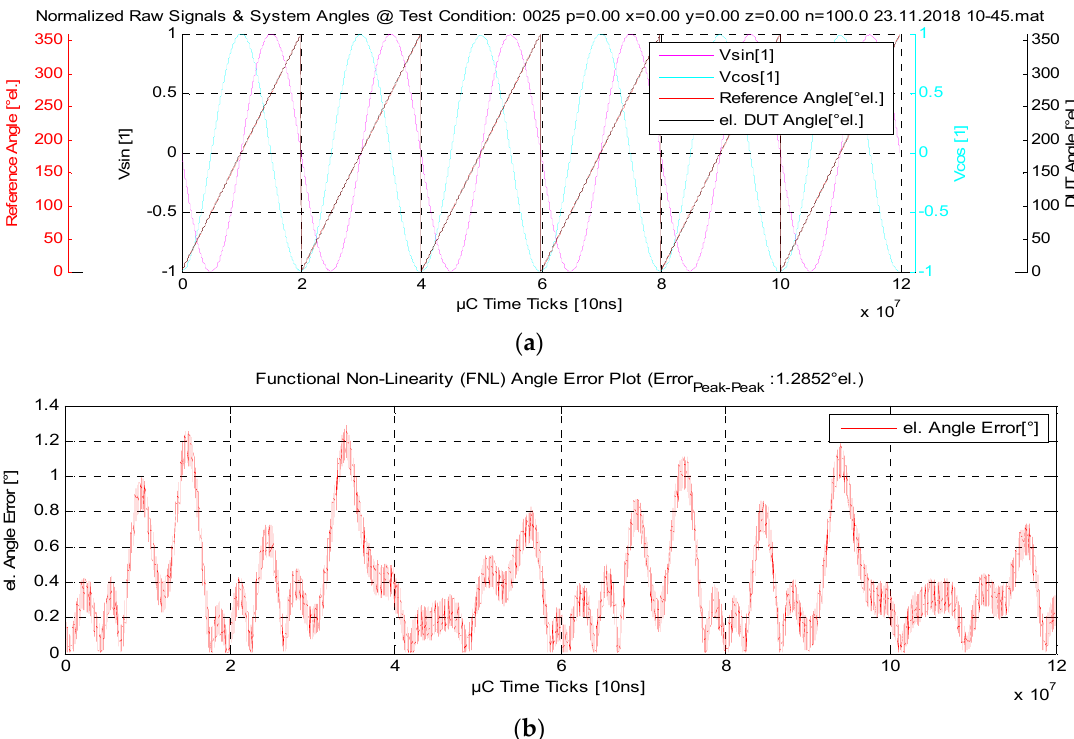
Figure 20. Resulting panels. ( a ) Merged result of the offline post processing method containing the electrical reference angle (red curve), electrical DUT resolver angle (black curve) as well as normalized and symmetrical sine (magenta) and cosine (cyan) DUT resolver feedback signals. Last two signals enable a sensor signal quality analysis. ( b ) Potential characterization output providing FNL angle error analysis as a subtraction of reference and DUT angle.